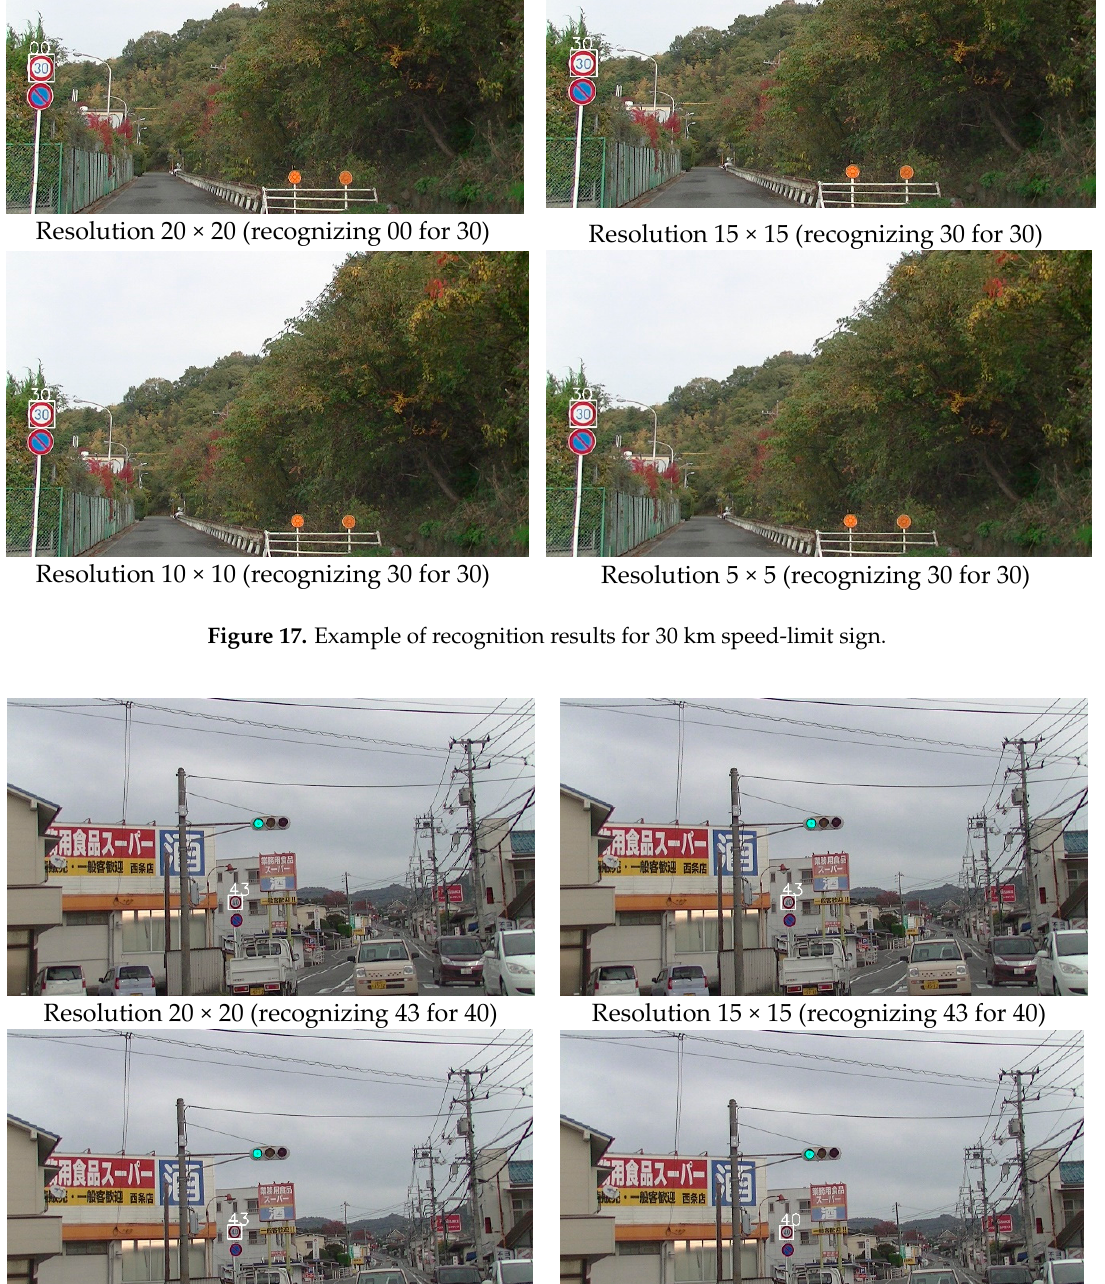
Figure 18. Example of recognition results for 40 km speed-limit sign.